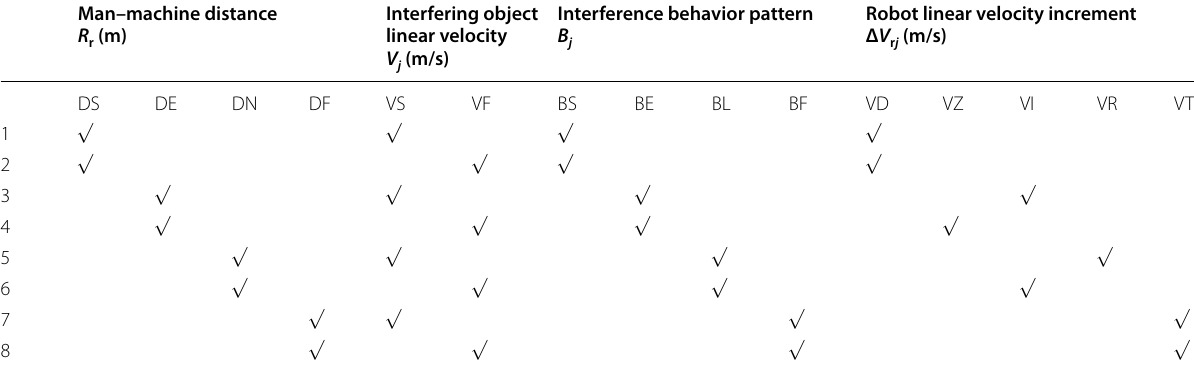
Man–machine distance R r (m)